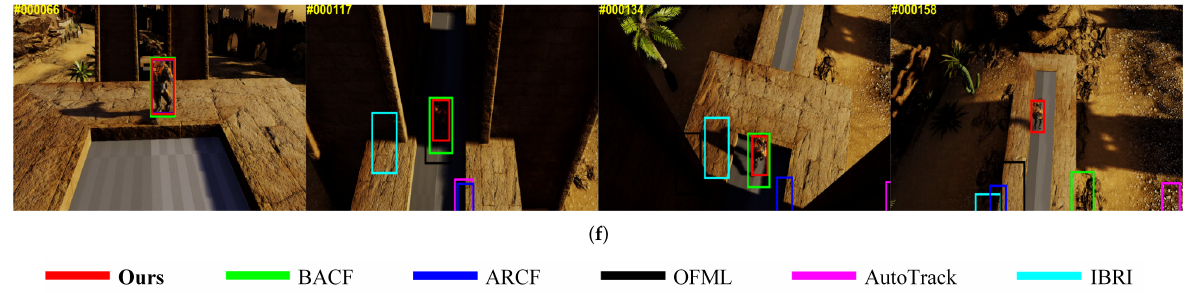
Figure 11. Qualitative evaluation on 6 challenging video sequences of the UAV123@10fps [45] benchmark. ( a ) Car1-2. ( b ) Person19. ( c ) Wakeboard5. ( d ) Uav1-2. ( e ) Car1-s. ( f )